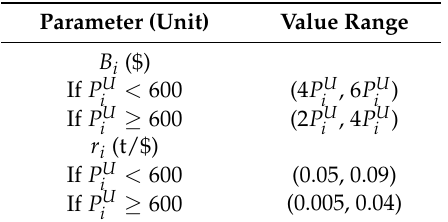
Table 1. Value ranges for startup costs and emission